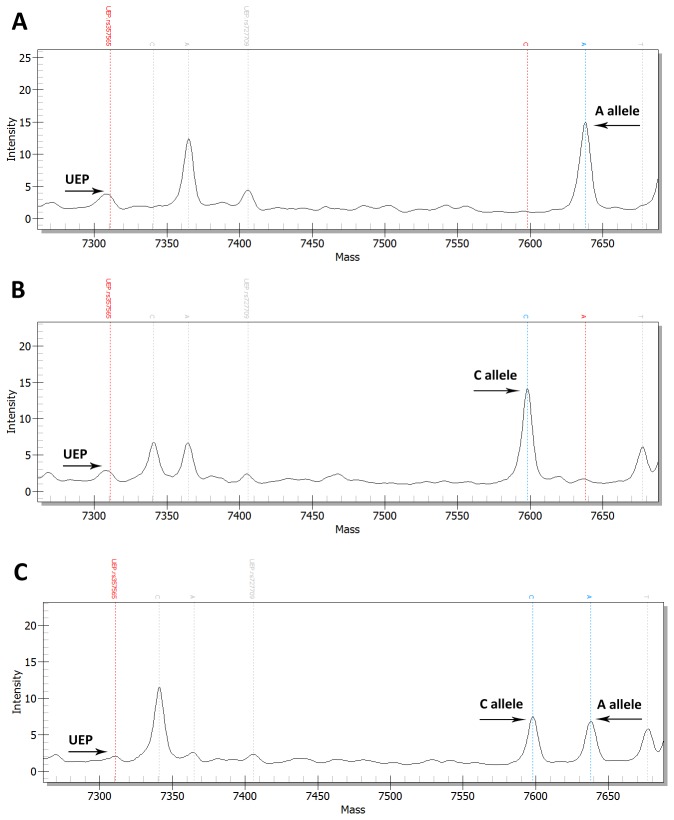
Representative mass spectra of the MassArray reactions including the three genotypes (A: A/A; B: C/C; C: A/C) of SNP rs357565.The alleles and UEP (unextended primer) are indicated with thick horizontal arrows.